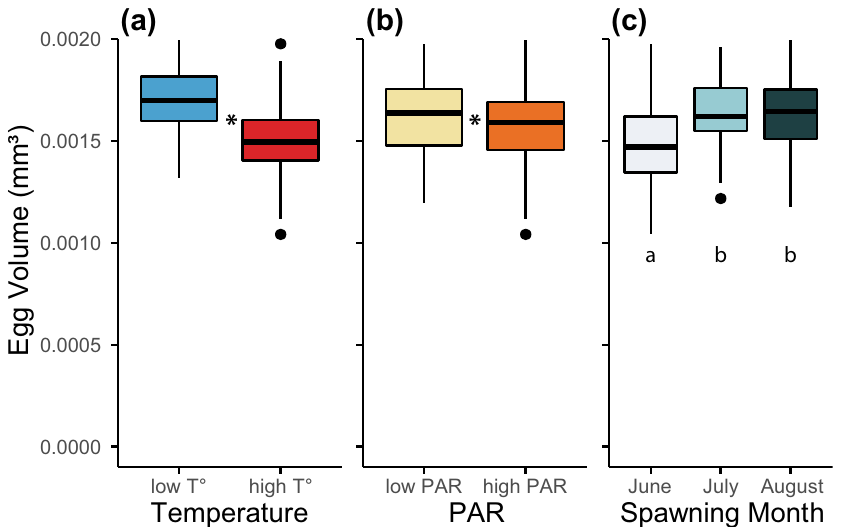
Figure 6. The size of the eggs that were released each month was affected by temperature ( a ), PAR ( b ), and the month that the eggs were released ( c ). Higher temperatures yielded a smaller egg size, as did high PAR levels. In June, the eggs were smaller than in July and August. A star * means that the treatments were significantly different from each other. Treatments that share the same letter are not significantly different from each other.